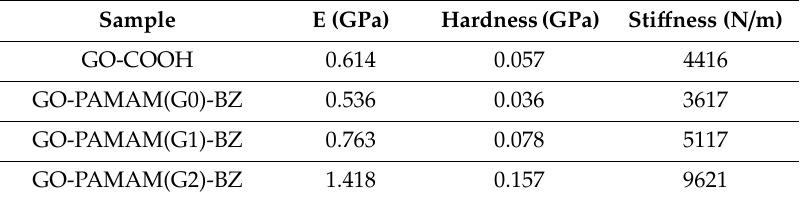
Figure 13. Nanomechanical properties: ( a ) Young’s modulus and ( b ) sti ff ness and hardness of the raw Table 5. Mechanical properties of GO-COOH and GO-PAMAM(G0÷2)-BZ materials obtained by material (GO-COOH) and hybrid materials. nanoindentation. Table 5. Mechanical properties of GO-COOH and GO-PAMAM(G0 ÷ 2)-BZ materials obtained by